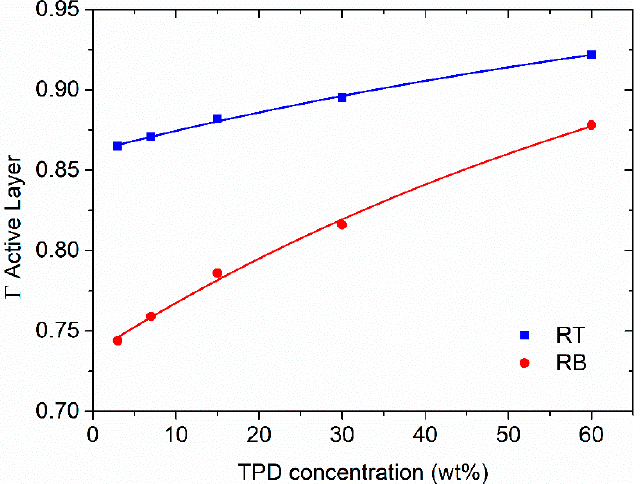
Figure 8. Optical electric field confinement factor, Γ , of the fundamental waveguide mode TE 0 in the active film as a function of the TPD concentration for RB and RT configurations.